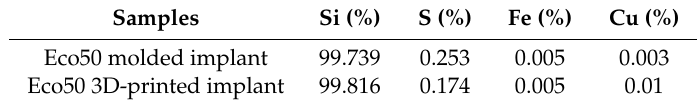
Table 2. Atomic Composition obtained for molded and 3D Printed Silicone